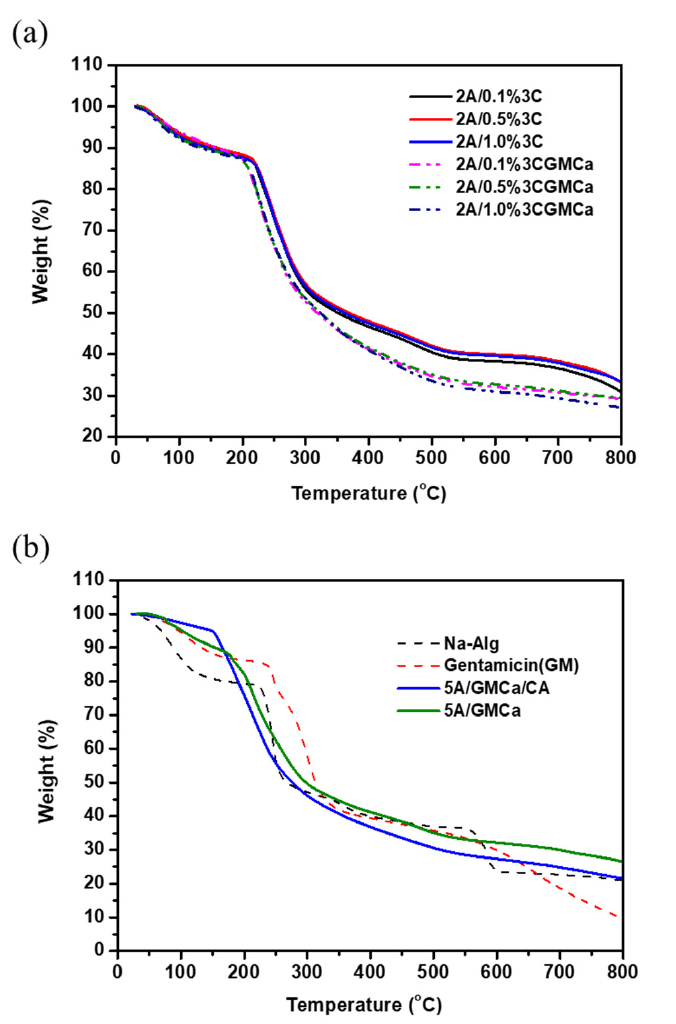
Figure 3. TGA thermograms of ( a ) alginate-chitosan (2A/x%3C; x = 0.1, 0.5, 1.0) beads with different chitosan content, and ( b ) alginate beads: alginate-only (5A), with gentamicin (5A/GMCa), and with gentamicin and then crosslinked with citric acid (5A/GMCa/CA).